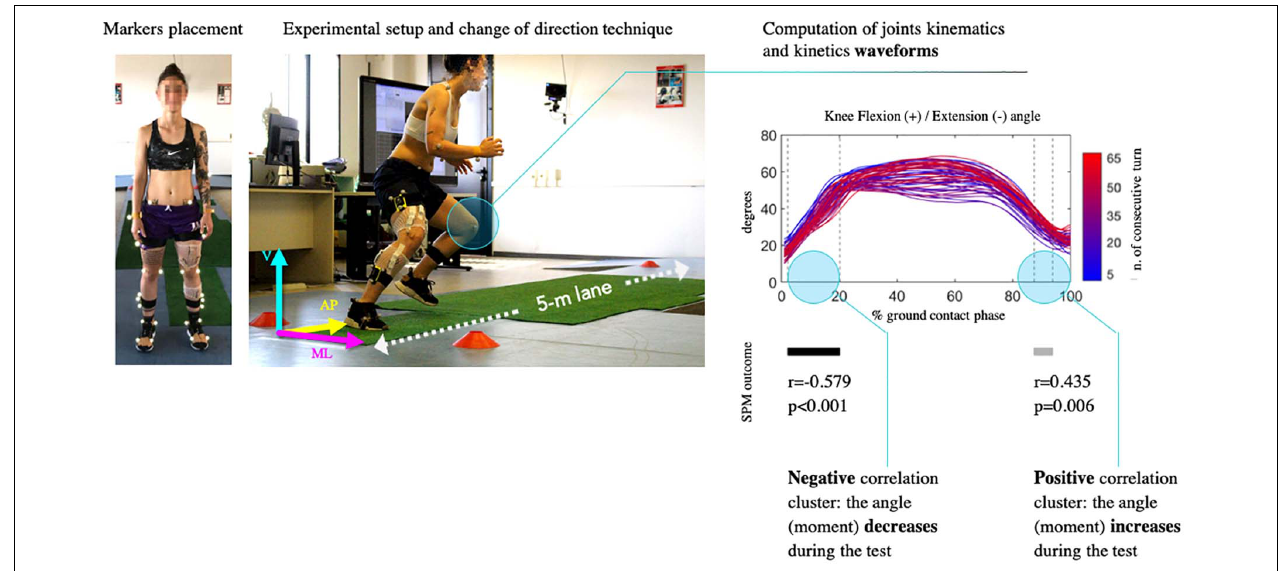
FIGURE 2 | (Left) Experimental setup. Kinematic and kinetic curves were evaluated during the ground support phase of all the changes of directions performed throughout the test with the dominant limb; direction of ground reaction forces was displayed (ML, mediolateral; AP, anteroposterior; V, vertical). (Right) Statistical analysis procedure. A linear regression for continuous variables was then applied between the time series of the angle and the number of consecutive turn (in the example plot, the curves fade from blue to red as the number of changes of direction increases). Statistical parametric mapping (SPM) returned clusters of significantly positive (gray bars) or negative (black bars)